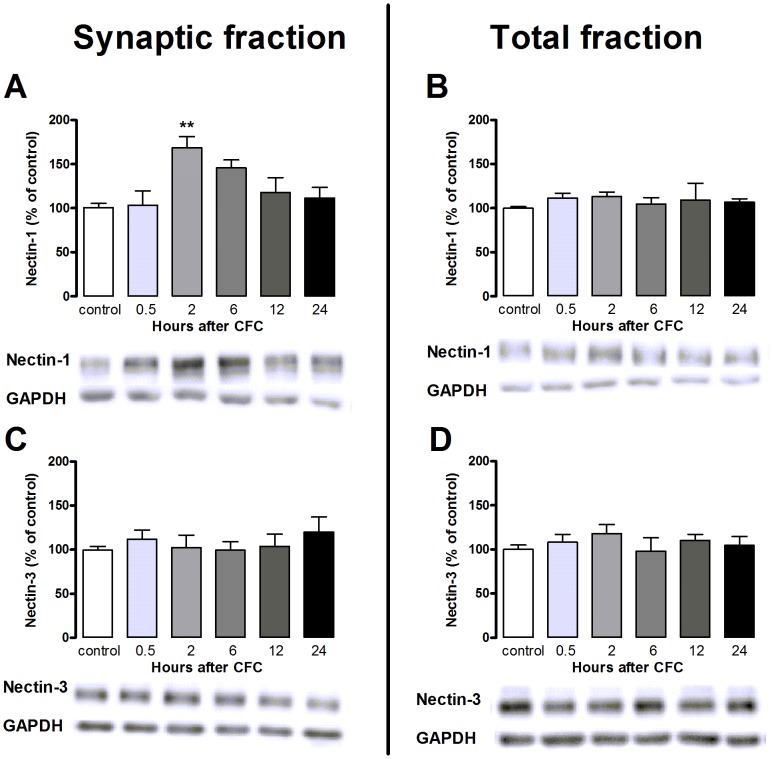
Effect of contextual fear conditioning on nectin-1 (A, B) and nectin-3 (C, D) protein expression in synaptic and total fractions.Synaptic nectin-1 expression was enhanced only at 2 h after CFC (A). Total fraction of nectin-1 (B) as well as synaptic- (C) or total nectin-3 (D) remained unaltered. Error bars represent standard error of the mean (n = 6 animals/group) (** p<0.01 vs. control group indicated by Bonferroni post hoc test).